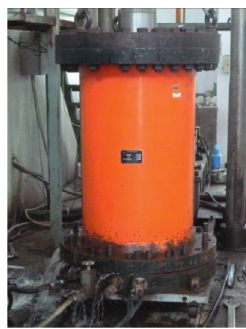
Figure 2: TYD-1500 dynamic triaxial tester. Table 2: Multistage unloading-reloading sequences in the triaxial tests of LCSG materials with cementing agent contents of 60 and 100kg/m 3 . Test